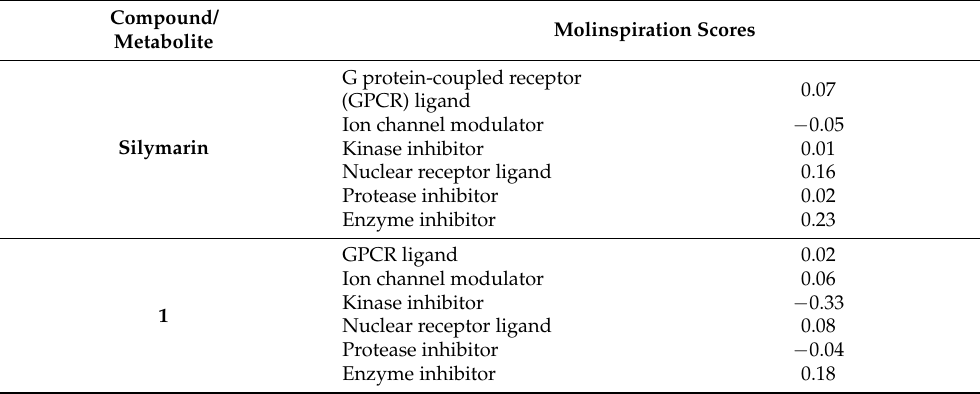
Table 2. Predicted biological targets for BERM-derived metabolites using the Molinspiration web